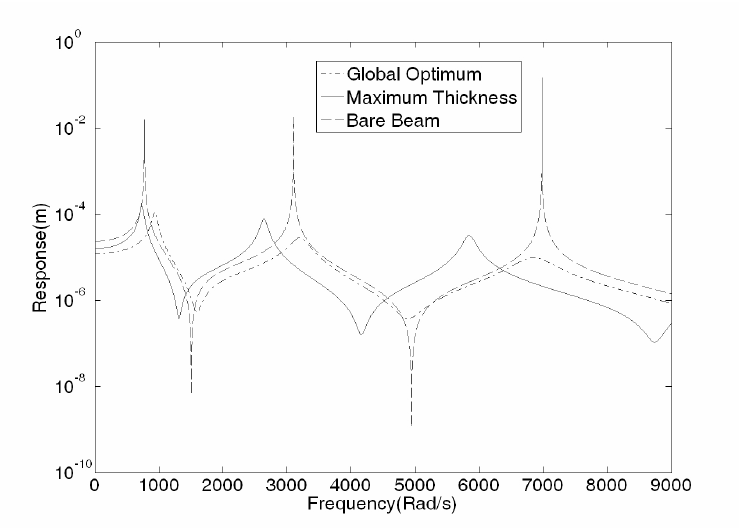
Fig. 11. Comparsion between the bare beam, the overall optimum configuration and the configuration with maximum thickness of damping layer and constraining layer. respectively. The response for a bare beam with a thickness of 0.0042 m is also shown for comparison purposes. The response for a damped beam having layer thicknesses that are the maximum allowed by the configuration limits (i.e. H 2 = H 2max and H 3 = H 3max ) is also shown. Not surprisingly, the overall optimum configuration